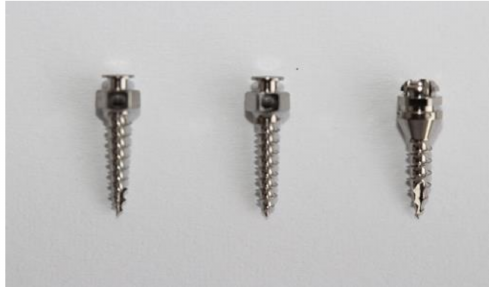
Figure 1. Mini-implants (right-to-left: Perfect Anchor 1.4 × 8 mm, 1.6 × 8 mm, and Tomas-pin 1.6 × 6 mm, respectively).